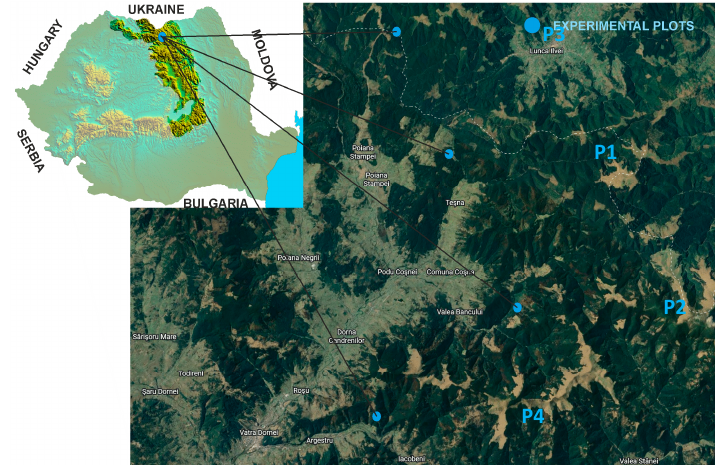
Figure 1. Location of the experimental plots.